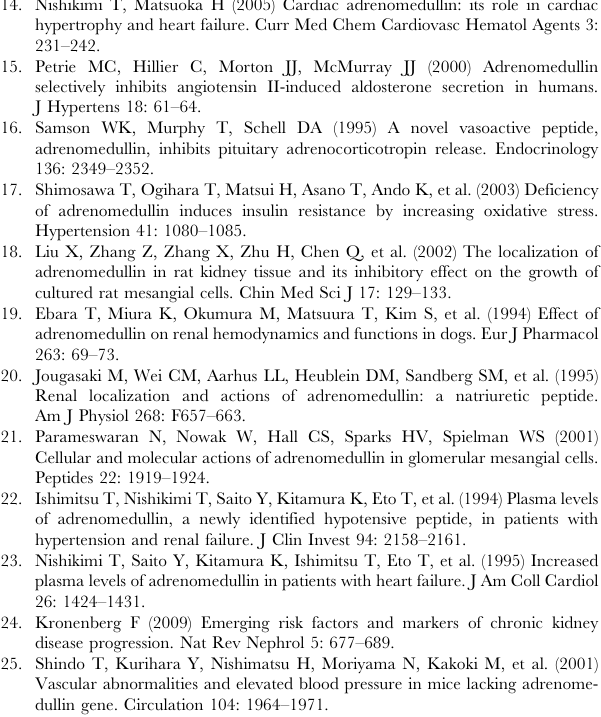
Figure S3 ER-stress related gene expression in STZ model. Quantitative real-time PCR analysis of BiP and CHOP after 4 weeks with STZ (250 mg/kg) administration. Data from the wild-type was assigned a value of 1. n =5 in each group. Bars are means 6 SEM. *p , 0.05. Figure S4 Urinary albumin level and megalin expres- sion in STZ model. (A) Comparison of urinary albumin after 4 weeks of STZ (250 mg/kg) administration. (B) Quantitative real- time PCR analysis of megalin with or without STZ. No change was detected between wild-type and RAMP2 + / 2 mice. Figure S5 Proximal tubule changes in STZ administra- tion. (A) Toluidine blue staining of renal cortex obtained from each mouse after 2 weeks of STZ (250 mg/kg) administration. Bars = 50 m m. (B) Low magnification electron micrograph of a section of proximal tubule. In RAMP2 + / 2 , tubular atrophy, microvesicular degeneration, and protrusion of luminal side of cell membrane were